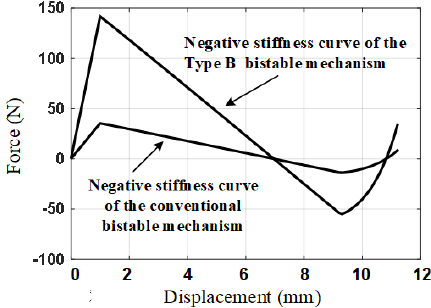
Figure 9. The axial force–displacement curve of the Type B bistable mechanism and of conventional bistable